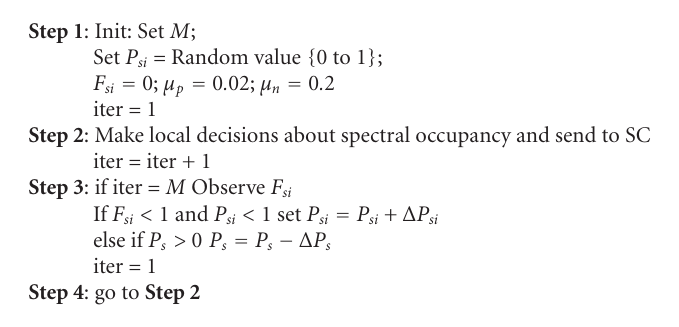
Algorithm 2: Adaptation algorithm at the SU “ i